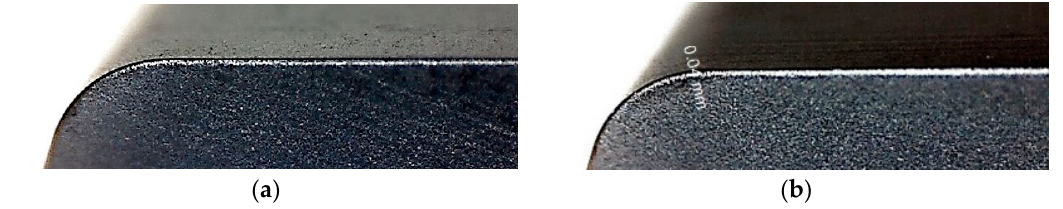
Figure 15. Tool wear of the special inserts of type 1010: ( a ) unused insert; ( b ) used insert after hard machining tests.